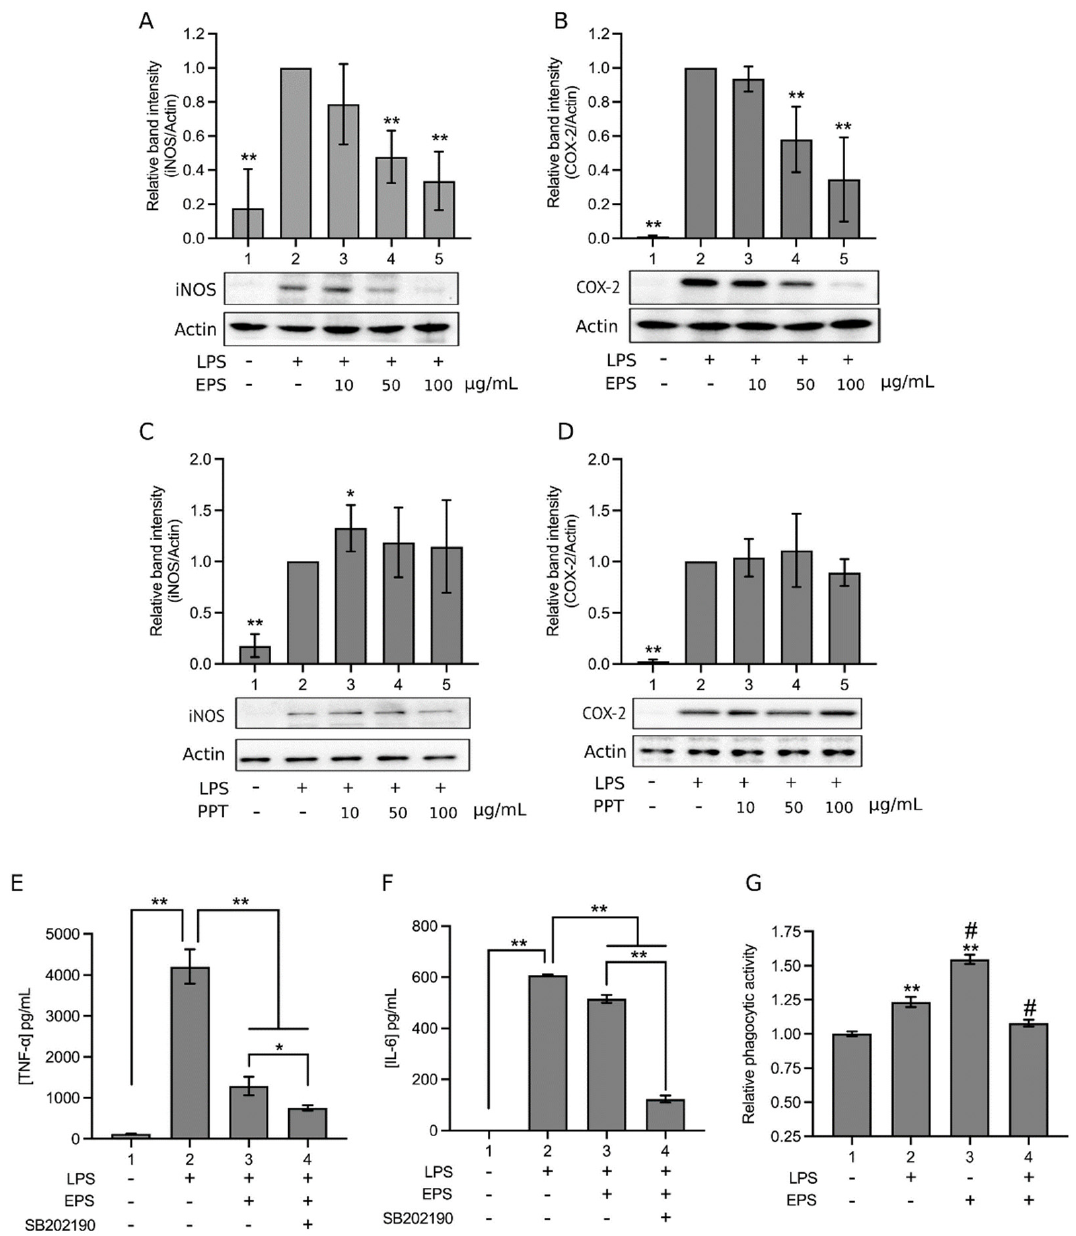
Figure 2. EPS reduced inflammatory biomarker levels in lipopolysaccharide (LPS)-treated THP-1 cells. ( A , B ) THP-1 cells were treated with vehicle, 1 µ g/mL LPS, or LPS and 10, 50, or 100 µ g/mL EPS for 16 h. The expression levels of inducible nitric oxide synthase (iNOS; A ) and cyclooxygenase-2 (COX-2; B ) in the cells were analyzed, using Western blotting. ( C , D ) the same experiments of ( A , B ) were performed, but EPS was replaced by PPT. Relative band intensity against Lane 2 was determined after normalization by actin. Data are presented as means ± standard deviations of four independent experiments. * p < 0.05, ** p < 0.005 vs. Lane 2. ( E , F ) THP-1 cells were treated with vehicle (Group 1), 1 µ g/mL LPS (Group 2), LPS and 100 µ g/mL EPS (Group 3), or LPS, EPS, and 20 µ M SB202190 (a p38 inhibitor; Group 4) for 16 h. The culture media were subjected to the concentration analyses of tumor necrosis factor- α (TNF- α ; E ) and interleukine-6 (IL-6; F ) by using ELISA. Data are presented as the mean ± standard deviation of an experiment in triplicate. * p < 0.05 and ** p < 0.005 between the indicated groups. ( G ) THP-1 cells were treated with vehicle (Group 1), 1 µ g/mL LPS (Group 2), 100 µ g/mL EPS (Group 3), or both LPS and EPS (Group 4) for 24 h, and the phagocytic activities of the cells were then analyzed. Data are presented as the mean ± standard deviation of an experiment in triplicate. ** p < 0.005 vs. Group 1; # p < 0.05 vs. Group